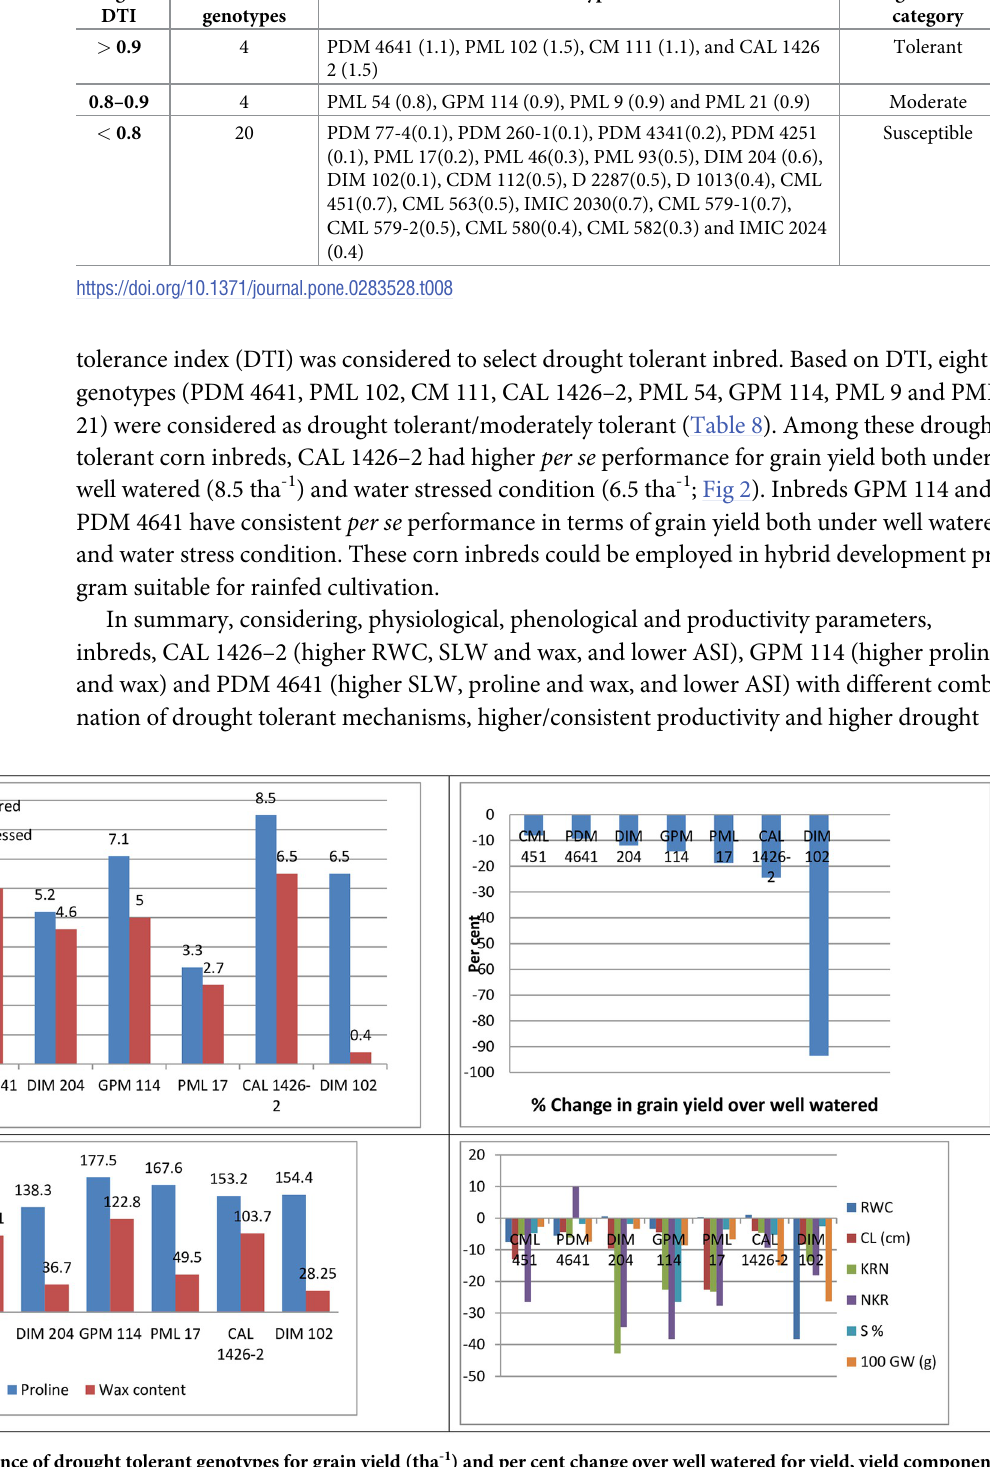
PLOS ONE | https://doi.org/10.1371/journal.pone.0283528 March 27,